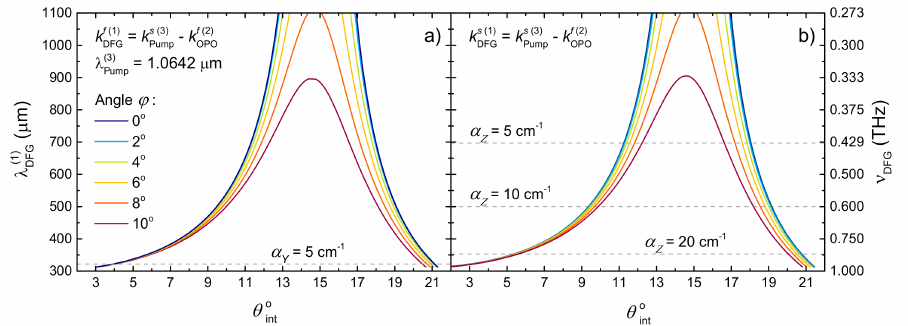
Figure 4. ( a ) Simulated s–f → f ; (b) s–f → s phase-matching curves for DFG of the laser radiation with the wavelength close to 1.0642 µ m, where k DFG – resulting terahertz wavevector, k pump , and k OPO are pumping waves with fixed (pump) and detuned via optical parametric conversion process (OPO) wavelengths lying in the vicinity of 1.0642 µ m, θ o is the internal phase matching angle inside crystal int with the unite of